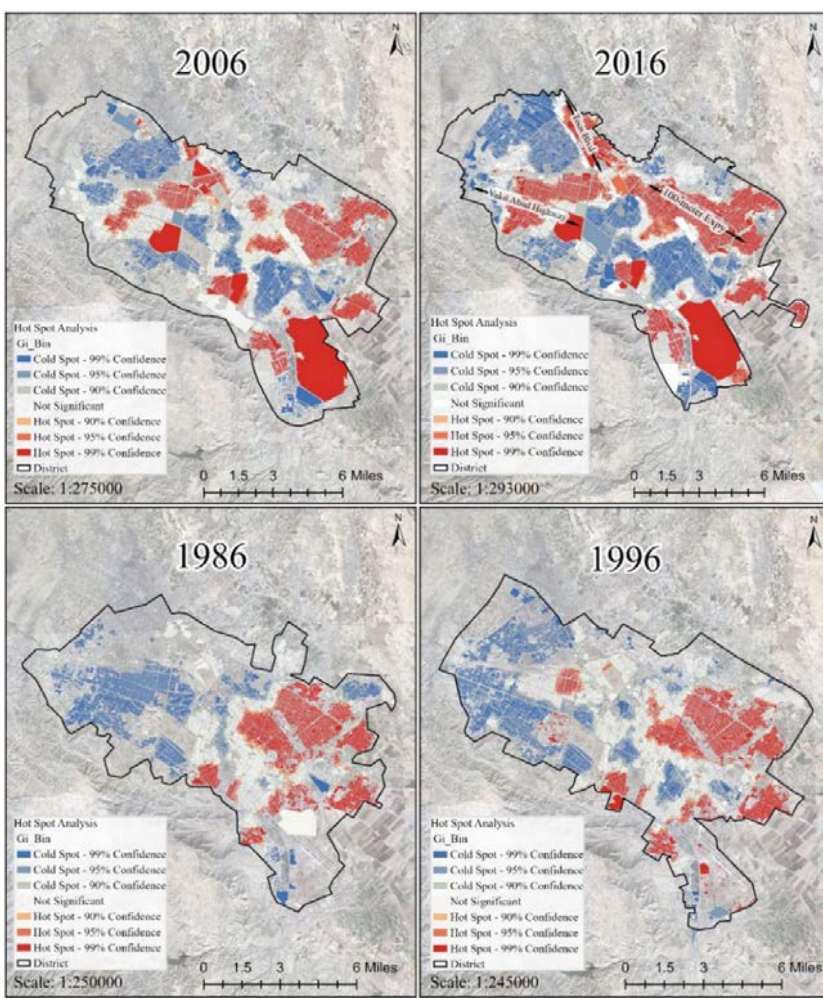
Fig. 3: Hotspot analysis output on the census block showing clustering of population